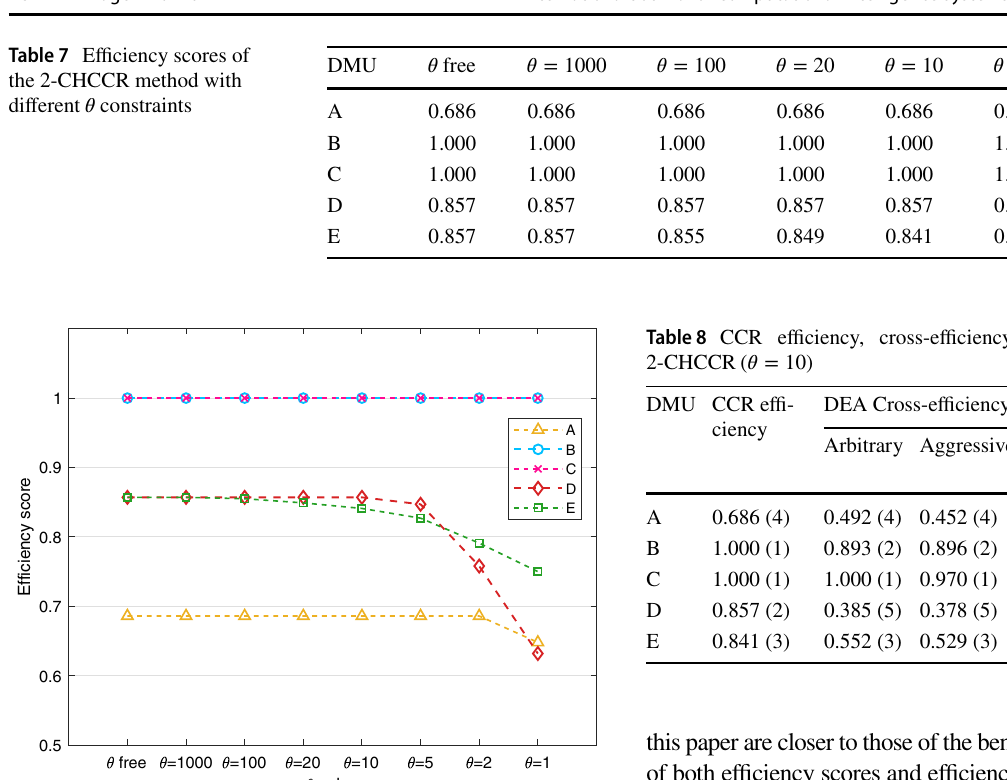
Fig. 2 Trends of the 2-CHCCR efficiency score versus the 𝜃 con- straint